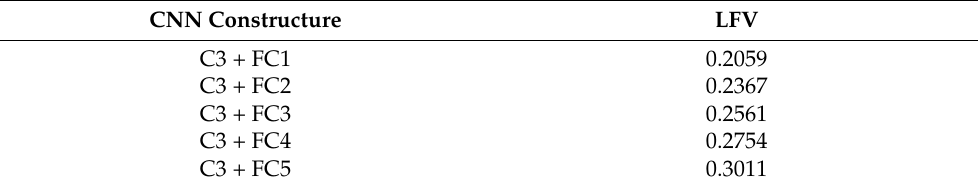
Table 5. LFVs of different FC layers with three Conv